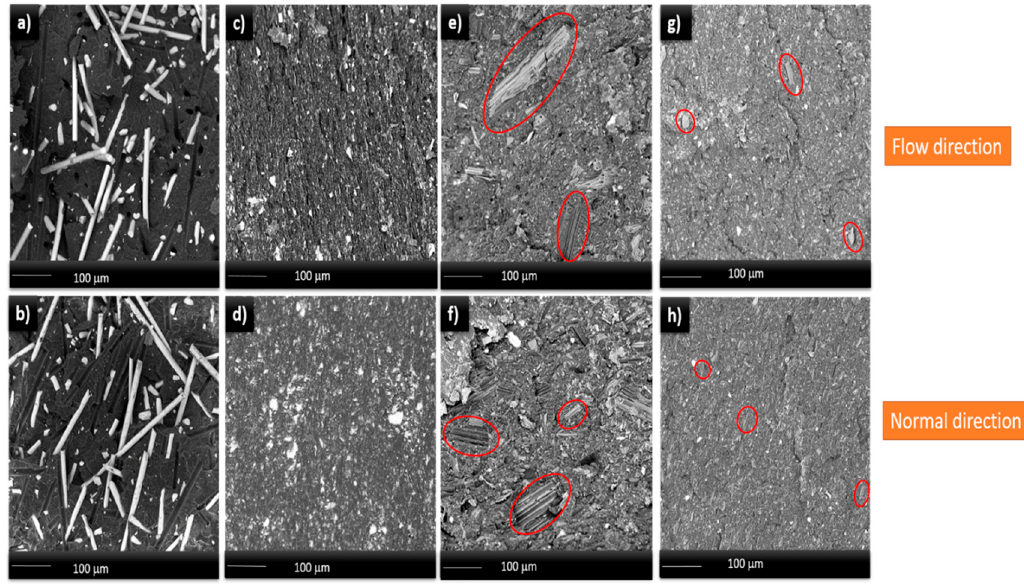
Figure 1. SEM images of PP with 30 wt.% ( a , b ) glass fiber; ( c , d ) talc; ( e , f ) BC 650; and ( g , h ) BC900 at 500×. ( a , c , e , f ) in flow direction and ( b , d , f , h ) in normal direction (the red ovals indicate biocarbon particles).